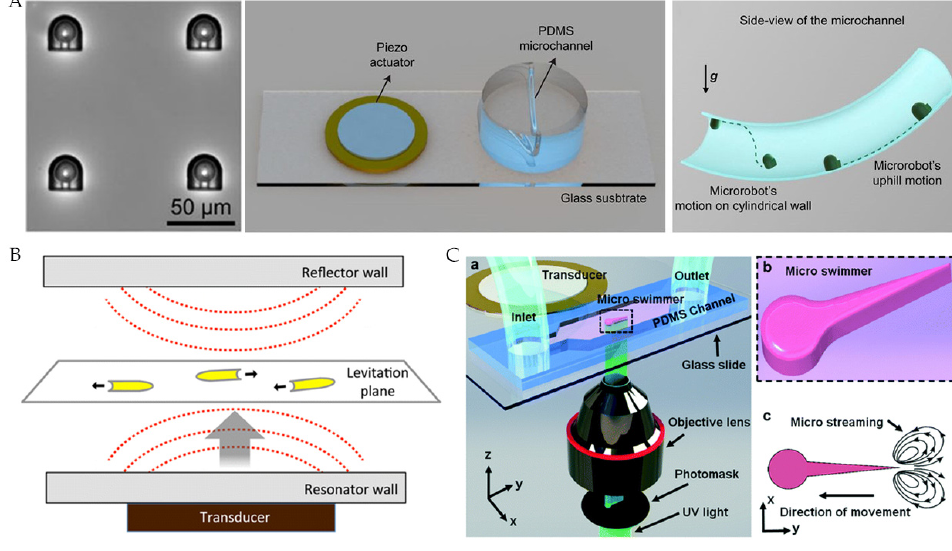
Figure 4. ( A ) Acoustic-actuated microrobot sliding on a 3D curved surface. Reproduced with permission from [44]; published by PNAS, 2020. ( B ) Standing waves actuated microrobot. Adapted with permission from [39]. Copyright 2016 American Chemical Society. ( C ) Acoustic-actuated bionic microswimmer. Reproduced with permission from [45]; published by Royal Society of Chemistry,